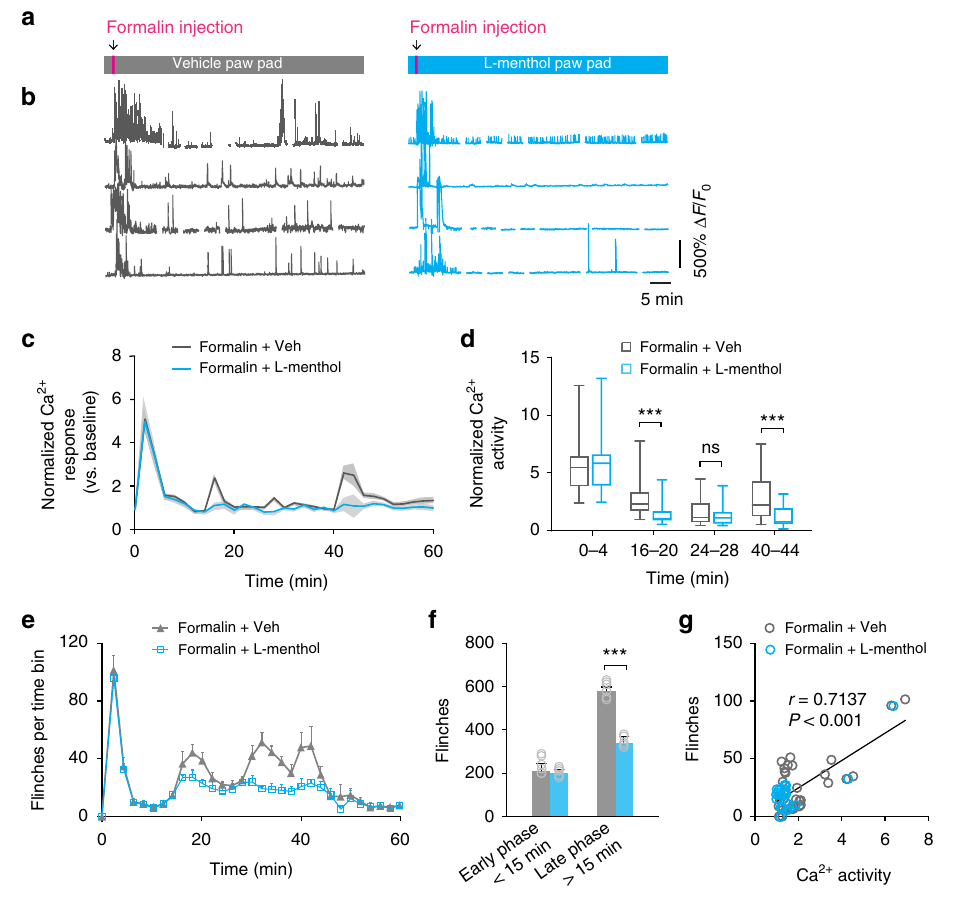
Fig. 5 Elevated Ca 2 + responses in DRG sensory neurons are associated with ongoing pain. a Experimental design. Pink box indicates the 20-s formalin injection period. Gray and blue boxes indicate vehicle and L -menthol pad application on the plantar surface of the injected hind paw. b Representative fl uorescence traces of DRG sensory neurons expressing GCaMP6s in control or L -menthol-treated mice over 60 min. c Population average response of DRG neurons after formalin injection in mice treated with L -menthol ( n = 97 neurons from four mice) or vehicle ( n = 73 neurons from three mice). Lines denote the mean and gray envelopes denote s.e.m. d Normalized neuronal Ca 2 + activity over 4-min recording ( L -menthol vs. vehicle, 0 – 4 min: 5.66 ± 0.28 vs. 5.50 ± 0.24, P = 0.947; 16 – 20 min:1.30 ± 0.09 vs. 2.56 ± 0.13, P < 0.001; 24 – 28 min: 1.27 ± 0.10 vs. 1.57 ± 0.11, P = 0.6435; 40 – 44 min: 1.22 ± 0.10